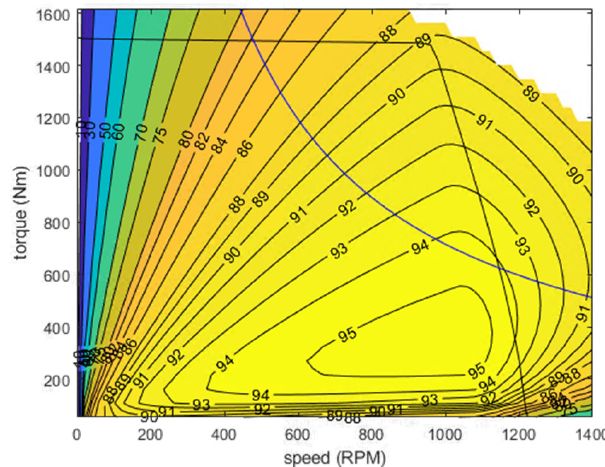
Figure 4. Motor efficiency plot for L1500 in-wheel machines. The black line shows the motor natural characteristics with field weakening.